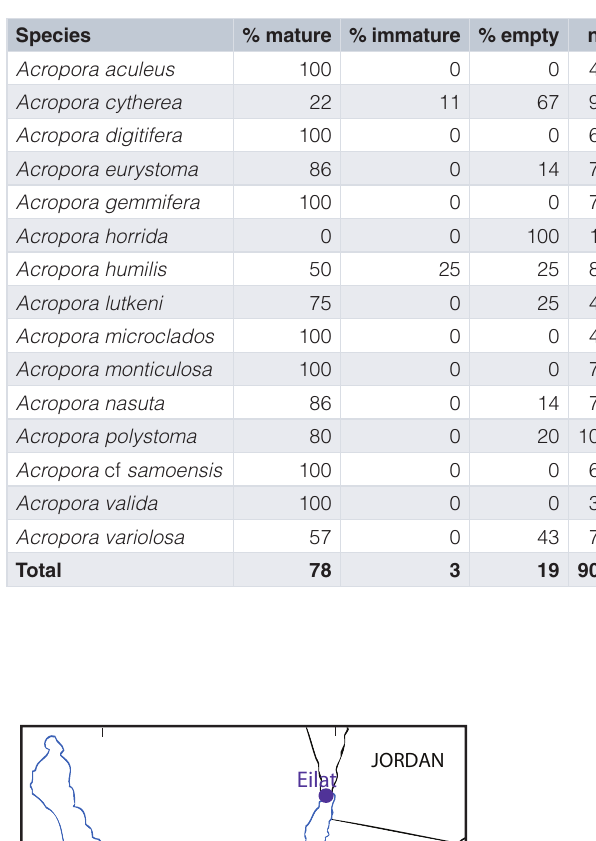
Table 1. Percentage (%) of Acropora colonies with mature, immature, and no visible oocytes, on the 2–4 June 2014, in Dahab, Egypt, in the Gulf of Aqaba, Red Sea. n: number of sampled